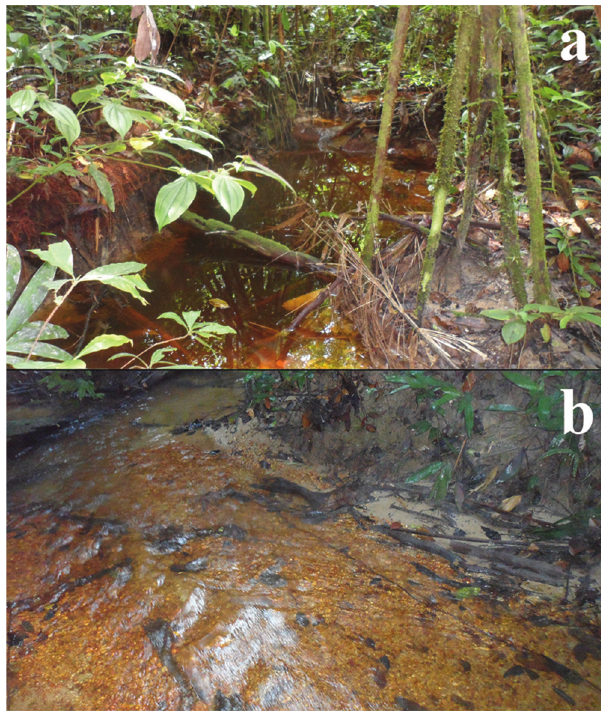
Fig. 5. Type-locality of Boehlkea weitzmani , tributary of the rio Japurá, Amazonas State, Brazil: a. small stream from right margin of rio Japurá, with litter banks; b. small stream from left margin of the river, predominantly composed by pebbles and